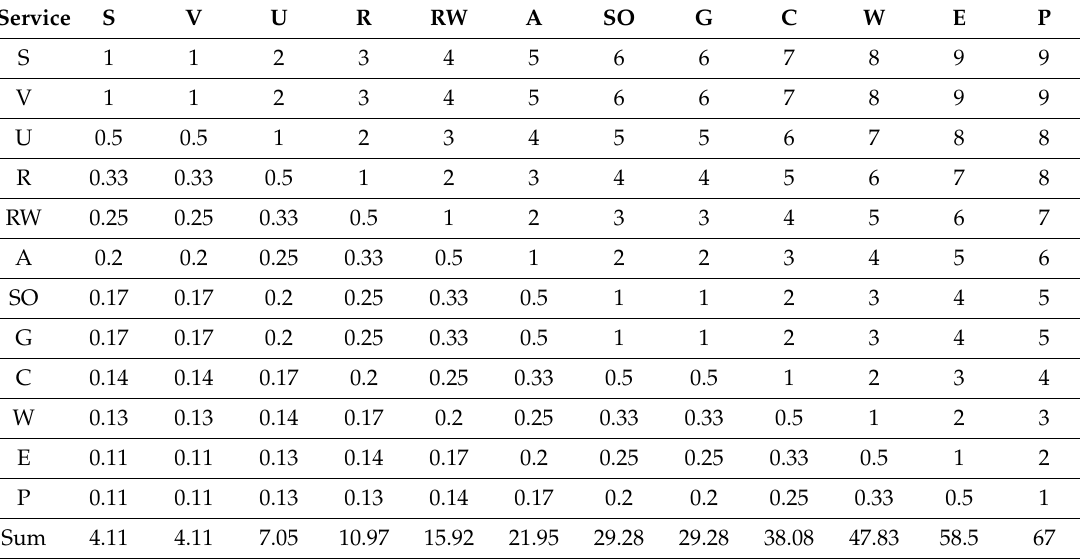
Table 4. The preferences values of the criteria using the AHP